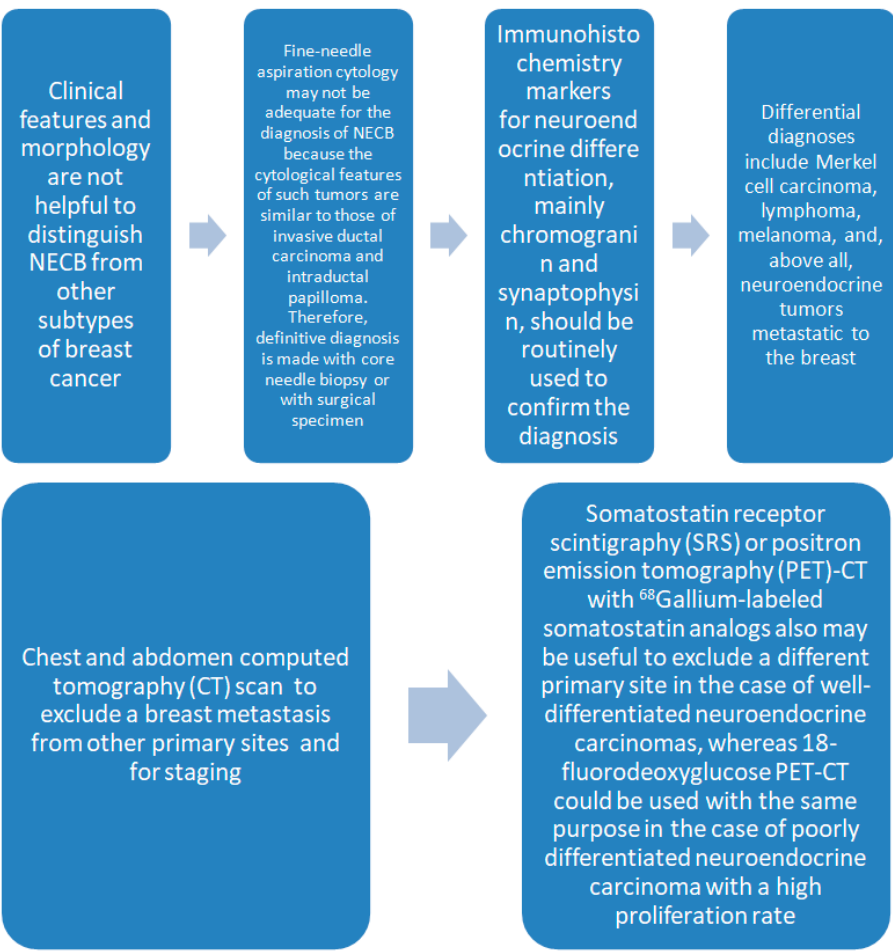
Figure 3. The diagnostic process in neuroendocrine breast cancer